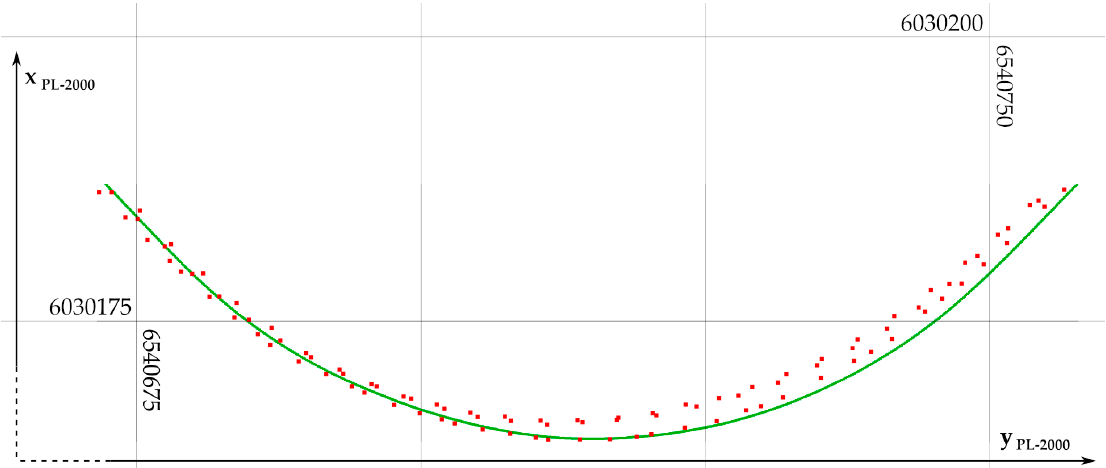
Figure 5. The tramway track position determined by the satellite compass in three test passages along the test route (red, frequency 1 Hz) and an analogous determination of the GNSS satellite receiver in one passage (green, frequency 20 Hz).